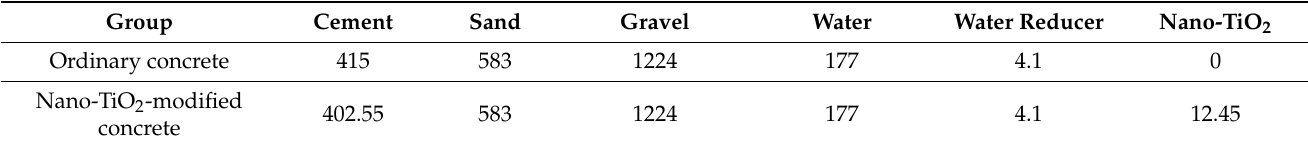
Table 3. Mixture ratio of the nano-TiO 2 -modified